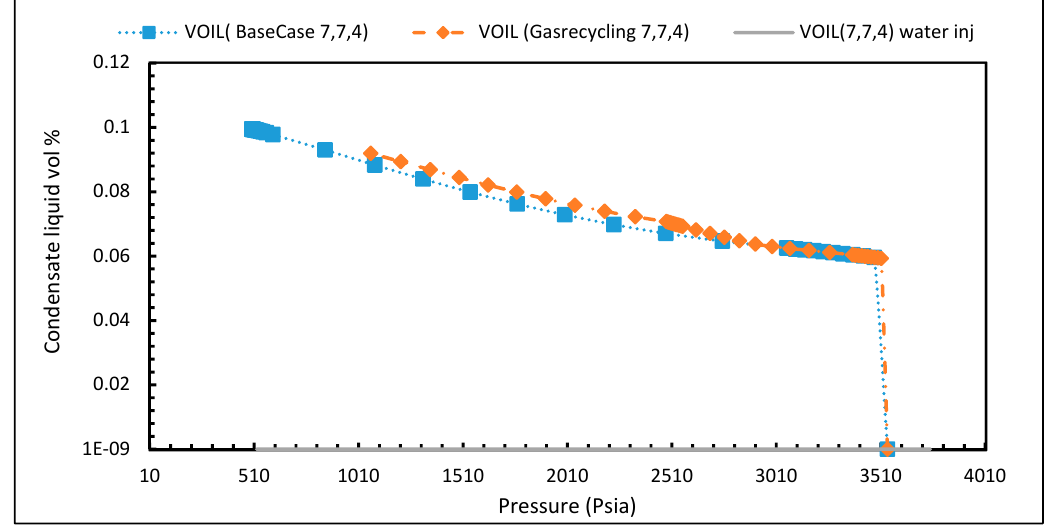
Figure 3. Condensate liquid volume dropout for block (7, 7, 4) as a function of pressure for the base case, gas recycling and water injection cases during depletion.